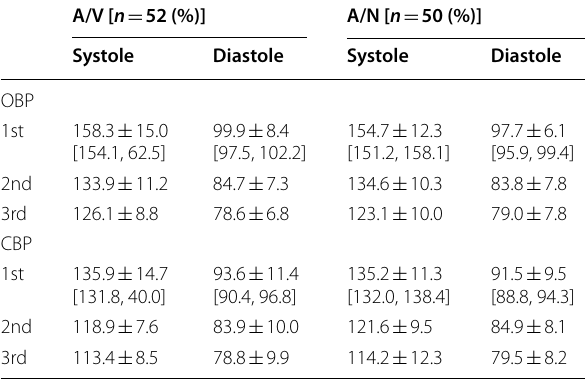
A/V, Amlodipine/Valsartan; A/N, Amlodipine/Nebivolol; OBP, office blood pressure; CBP, central BP; 1st, first visit without medications (A/V or A/N); 2nd, second visit (on either A/V or A/N); 3rd, visit (on either A/V or A/N) Table 4 Difference in BP over follow‑up visits Difference in BP